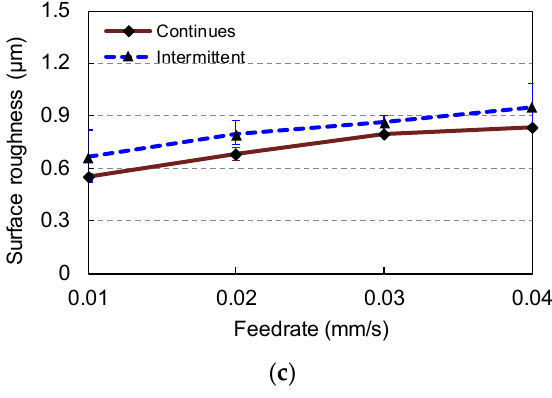
Figure 7. Effects on surface roughness. ( a ) Effects of ultrasonic amplitude; ( b ) Effects of tool rotation speed; ( c ) Effects of federate.